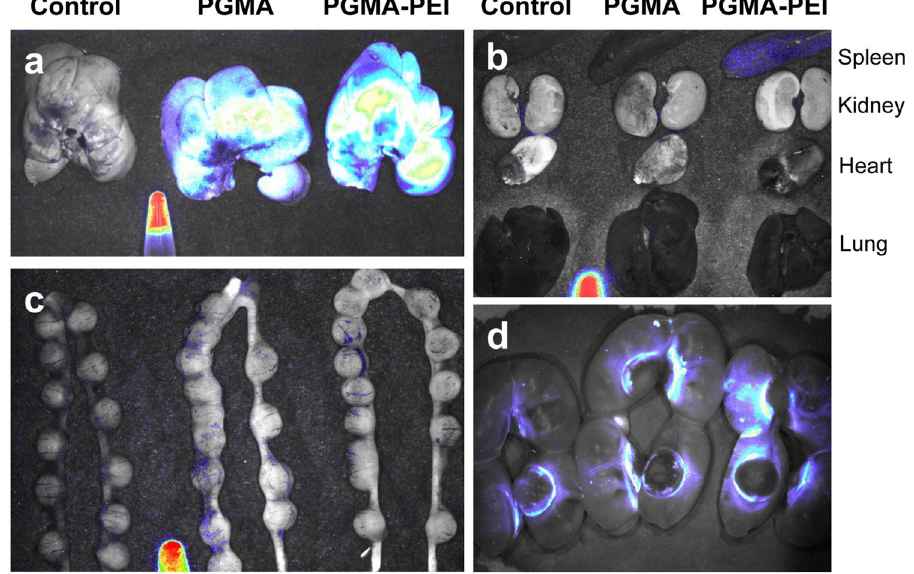
Figure 3. Whole tissue fluorescence imaging of representative ED10 and ED20 tissues. Spectral unmixing was performed using a tube containing PGMA-PEI nanoparticles as reference. ( a ) Livers of ED10 dams. High levels of fluorescence were observed in livers from both PGMA and PGMA-PEI treated dams. ( b ) Other organs of ED10 dams. With the exception of the spleen of the PGMA-PEI treated dam, none of the